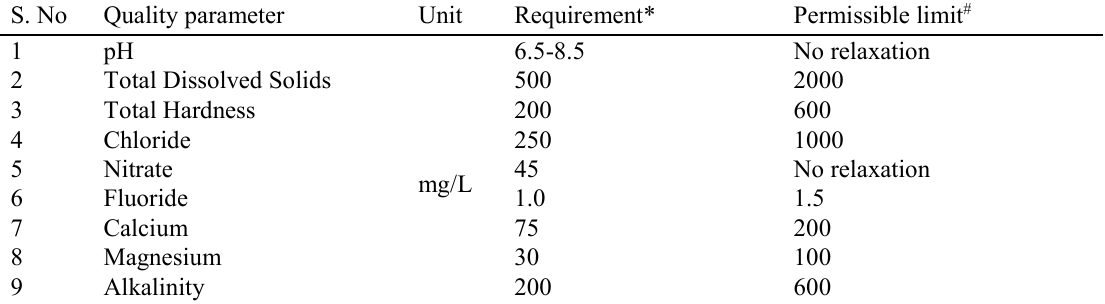
Table 2 Drinking Water Standards